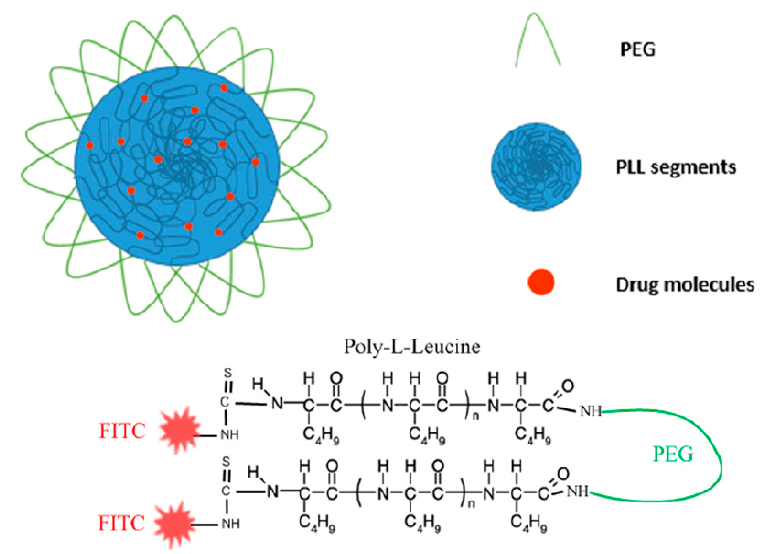
Figure 10. PLL-PEG-PLL chemical structure and nanoparticle design (nanomicelles) for drug loading and delivery.